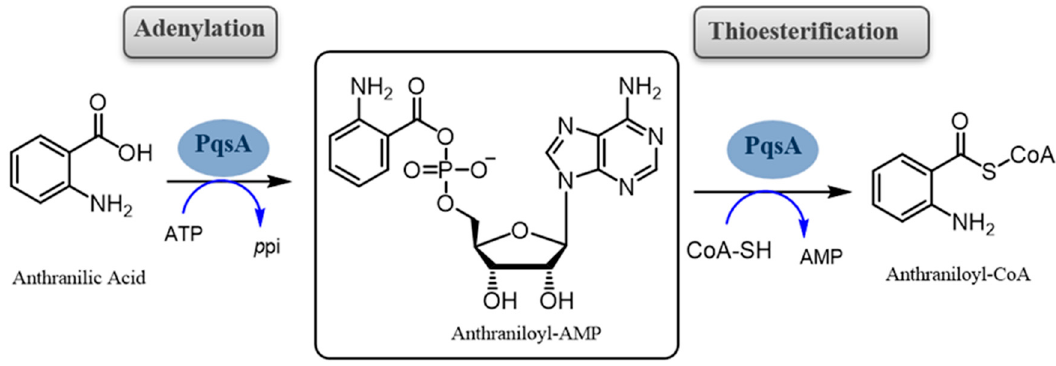
Figure 2. PqsA catalyzes the conversion of anthranilic acid to anthraniloyl-CoA—the first step of PQS biosynthesis.